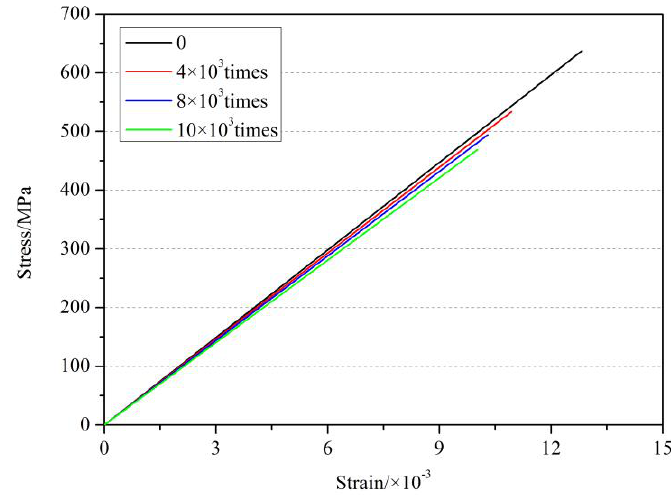
Figure 11. Stress-strain curve of GFRP bars under cyclic load at 350 °C and holding time of 0